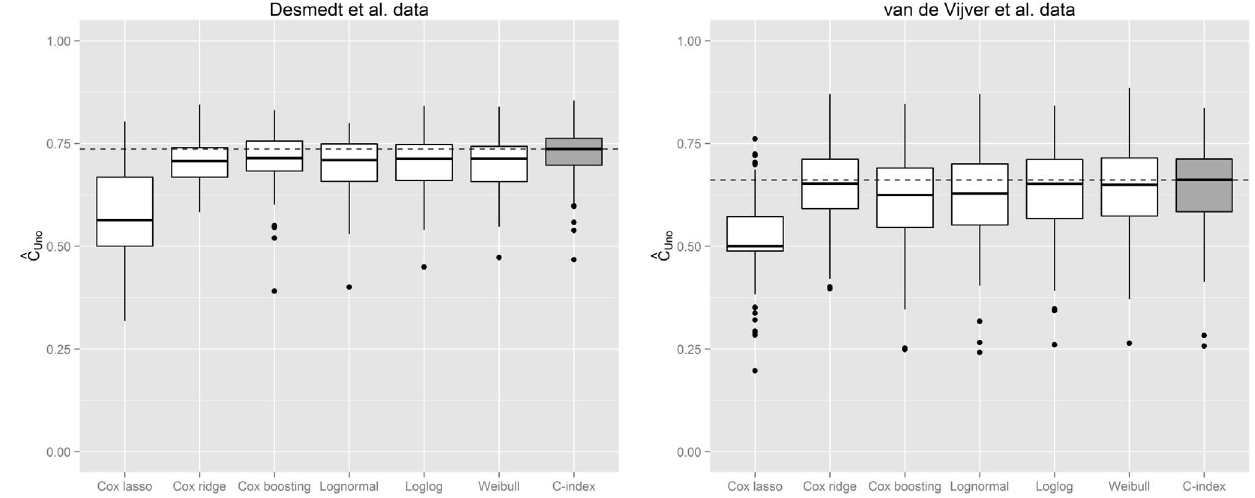
Figure 3. Comparing the discriminatory power of biomarker combinations to predict the time to distant metastases resulting from the proposed C -index boosting approach with competing estimation schemes. The plot on the left refers to the Desmedt et al. data, whereas the plot on the right presents results from the van de Vijver et al. data. All biomarker combinations were optimized via the corresponding algorithms based on the same 100 learning samples. Boxplots represent the empirical distribution of the resulting ^ CC Uno on corresponding test samples. The dotted line corresponds to the median C -index resulting from the new approach.